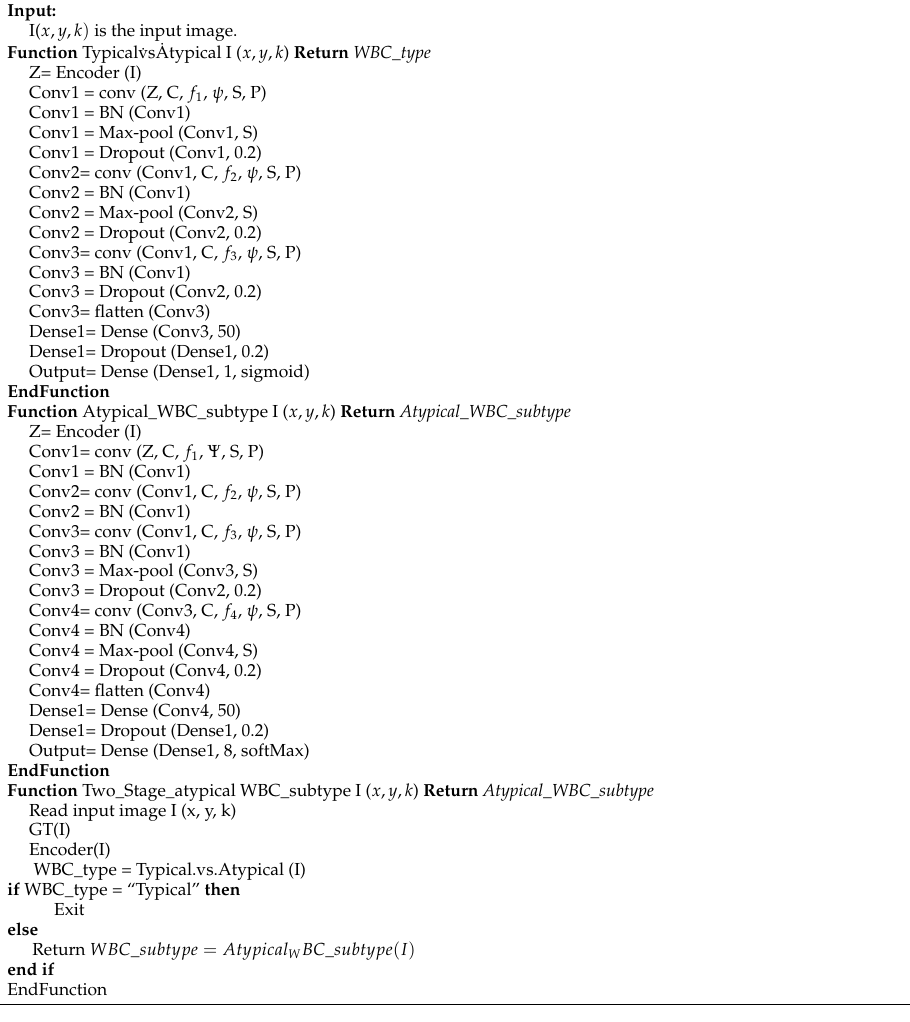
Algorithm 2 The two-Stage DCAE-CNN atypical WBC classification